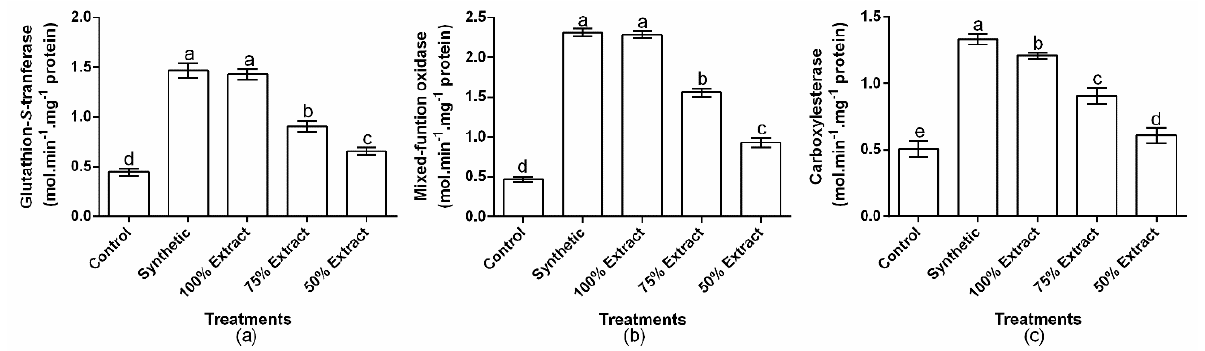
Figure 5. The effect of potato leaf extract on ( a ) glutathaionstransferase, ( b ) mixedfunction oxidase, and ( c ) carboxylesterate. Data represent the mean ± standard deviation of three replicates. Lowercase letters indicate means that are significantly different according to the LSD test ( p < 0.05). Note: synthetic pesticide (recommended rate of Beta cypermethrin).